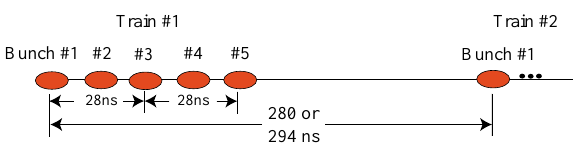
FIG. 2. (Color) There are nine trains of bunches in CESR. Each train is separated by 280 or 294 ns and can have up to five bunches per train. The spacing between bunches is 14 ns. The highest luminosity in CESR, at the time of the streak camera measurements, was achieved with bunches #2 and #5 occupied in each